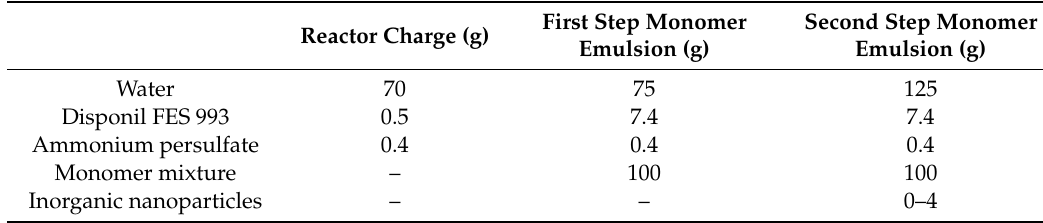
Table 1. Composition of polymerization